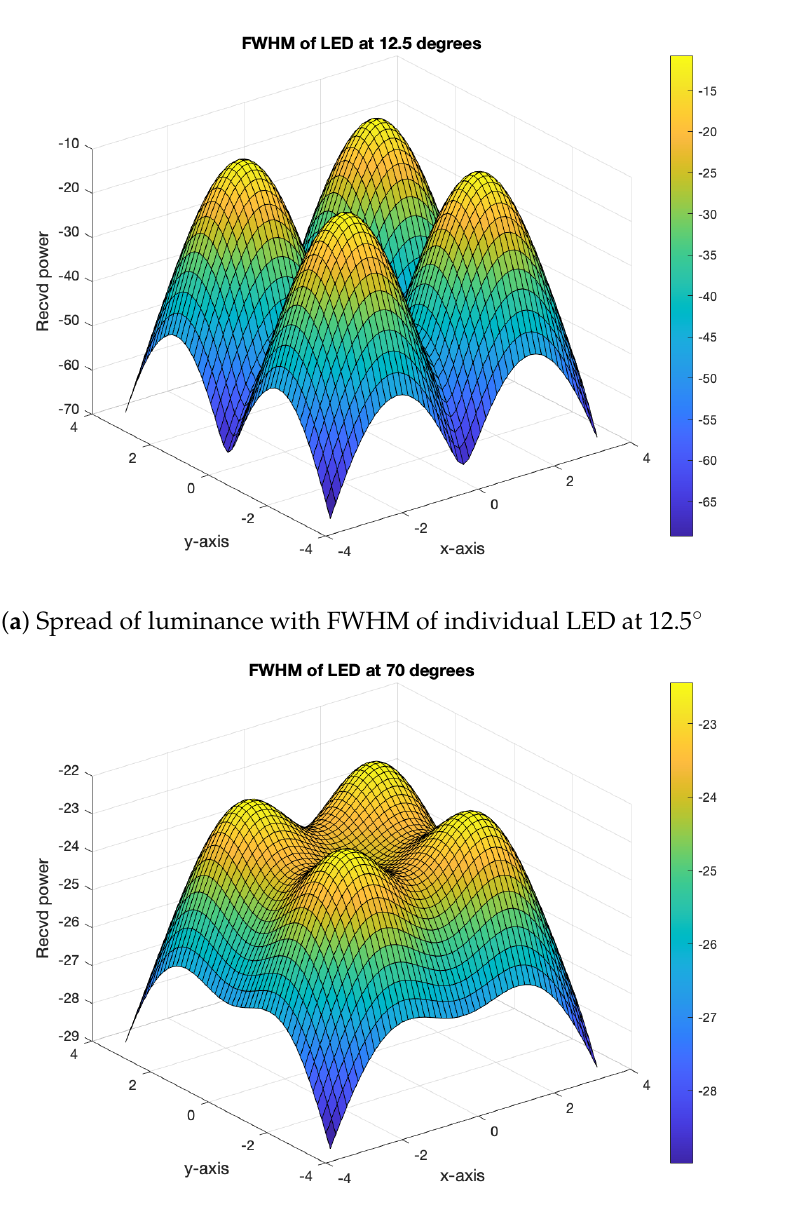
Figure 7. Distance-specific spread of luminance with